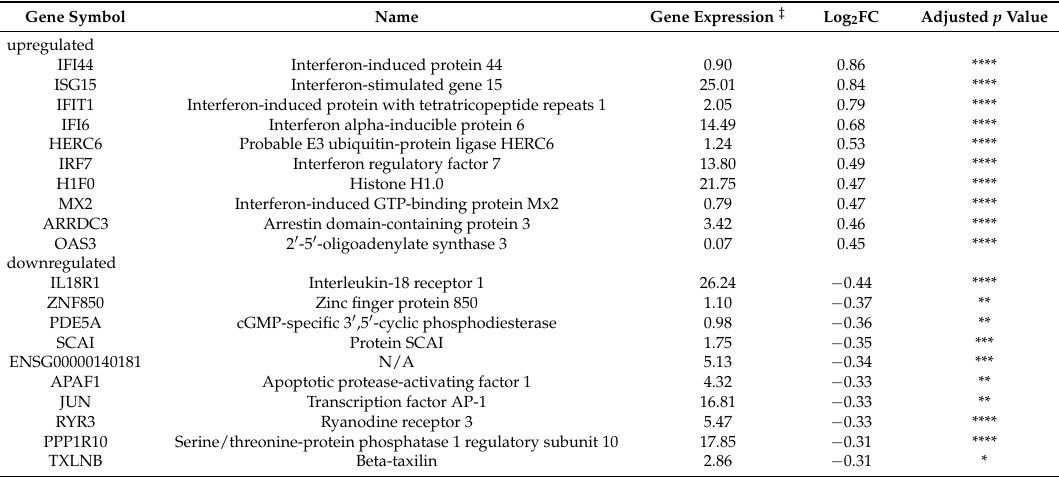
Table 3. The top-10 deregulated genes in TLR2-CCS versus